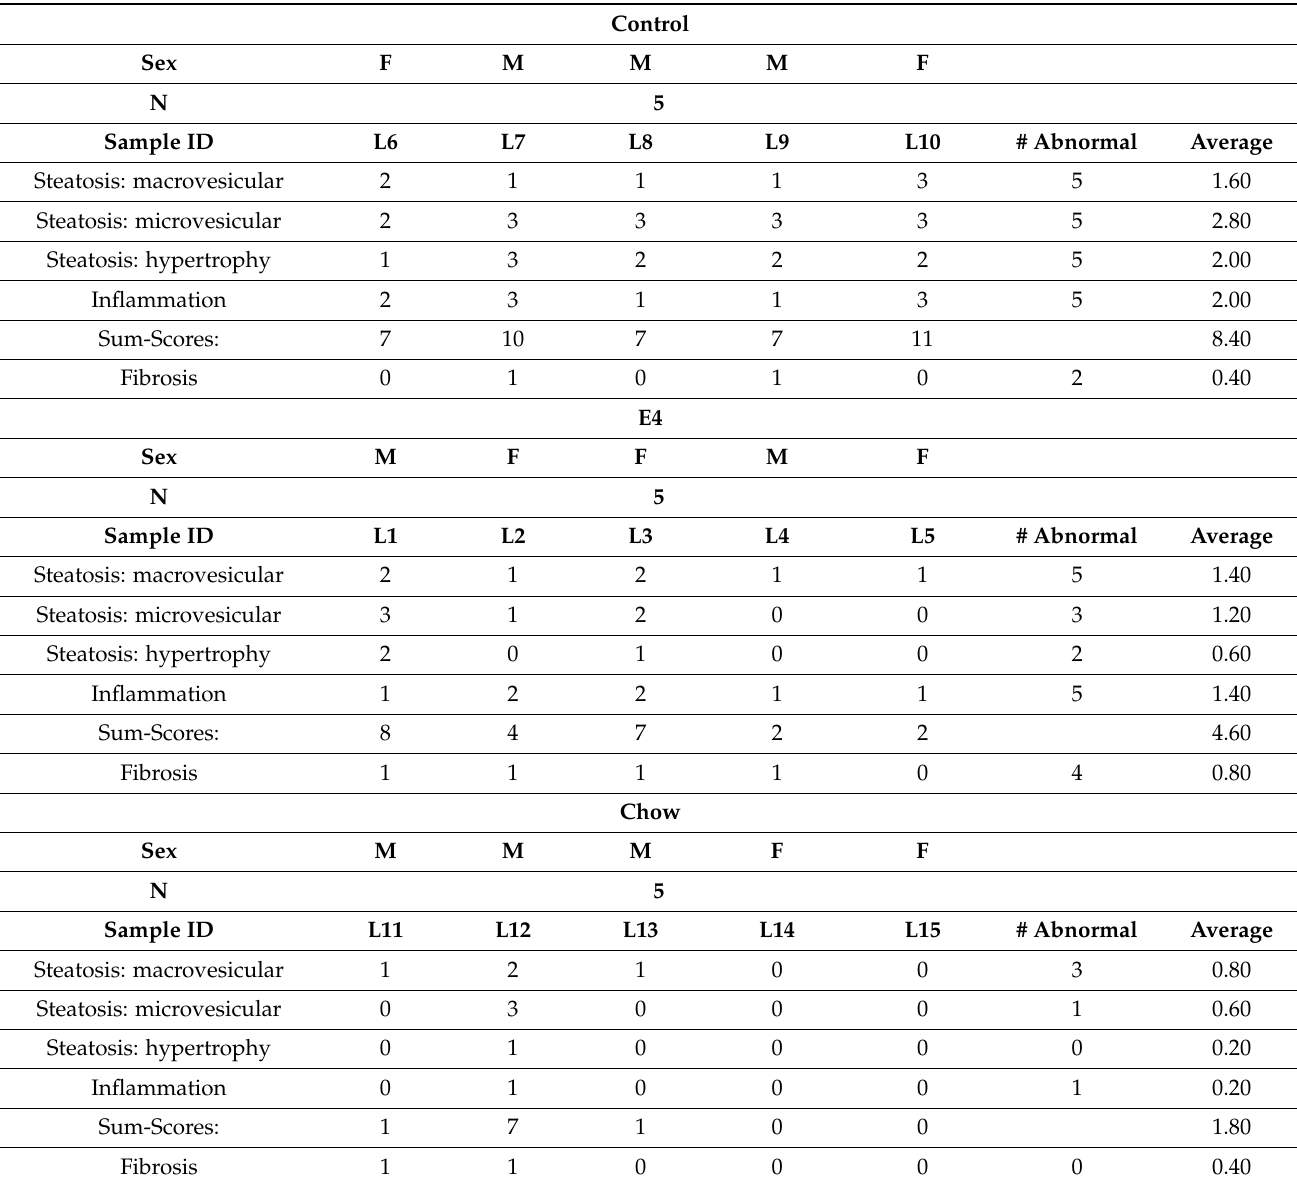
Table 1. Pathological score for histological hepatic tissue changes. Summary scores for the liver were calculated for lesions indicative of NAFLD/NASH, including macro-vesicular steatosis, micro-vesicular steatosis, hepatocyte hypertrophy, and inflammation as described in “Materials and Methods”.